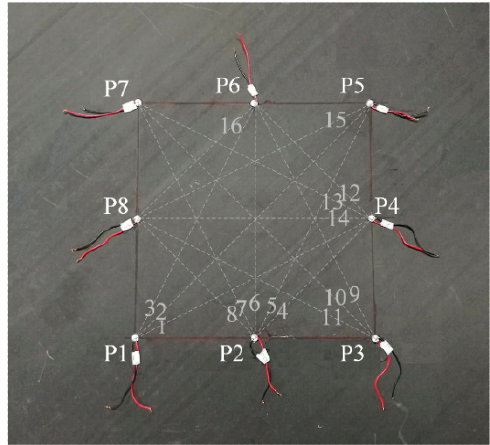
Table 2. Coordinates of the damage center and piezoelectrics (PZTs).